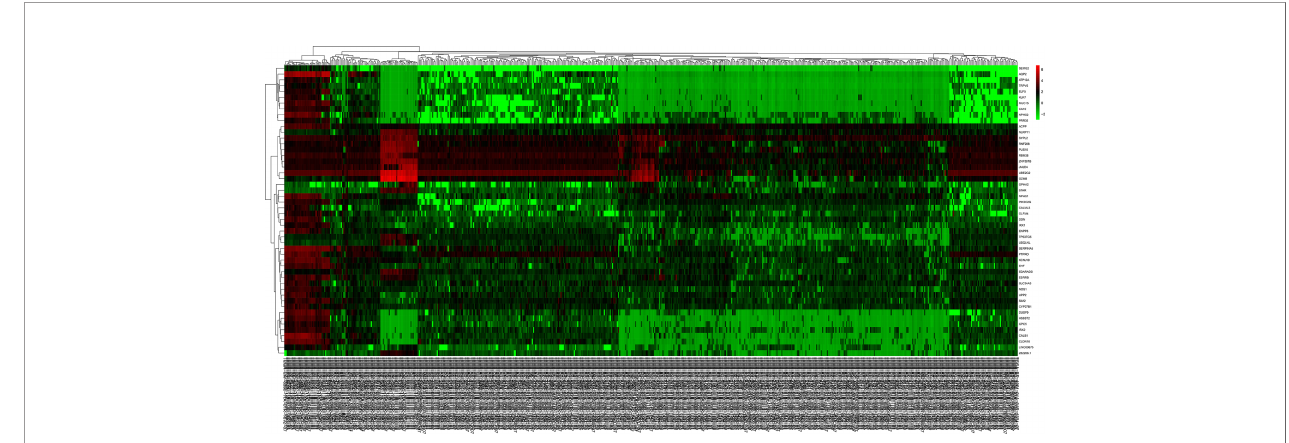
FIGURE 2 | The heat map of the top 50 DEGs in ccRCC and normal kidney tissue. Red squares indicate upregulated genes, green squares indicate downregulated genes, and black squares indicate genes without difference. DEGs, differentially expressed genes; ccRCC, clear cell renal cell